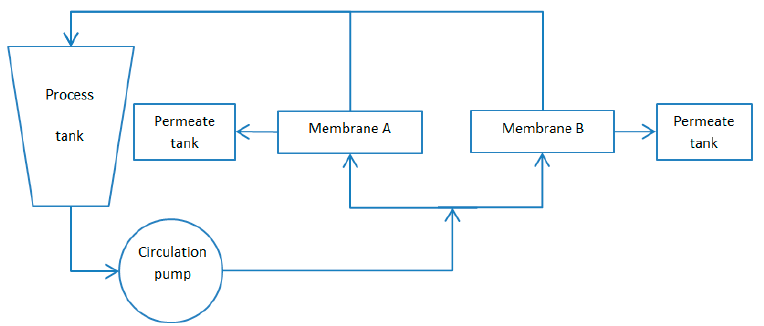
Figure 5. General scheme of the process in a membrane plant.